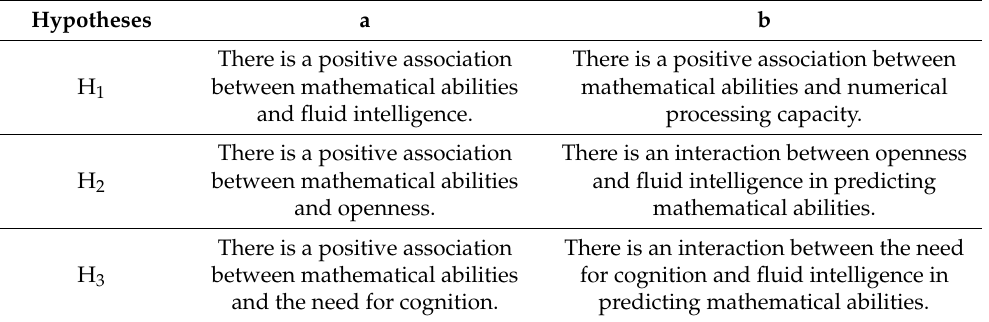
Table 1. Hypotheses of the current study. Hypotheses a b There is a positive association between There is a positive association mathematical abilities and numerical H 1 between mathematical abilities processing capacity. and fluid intelligence. There is an interaction between openness There is a positive association H 2 between mathematical abilities and fluid intelligence in predicting and openness. mathematical abilities. There is an interaction between the need There is a positive association for cognition and fluid intelligence in H 3 between mathematical abilities predicting mathematical abilities. and the need for cognition.